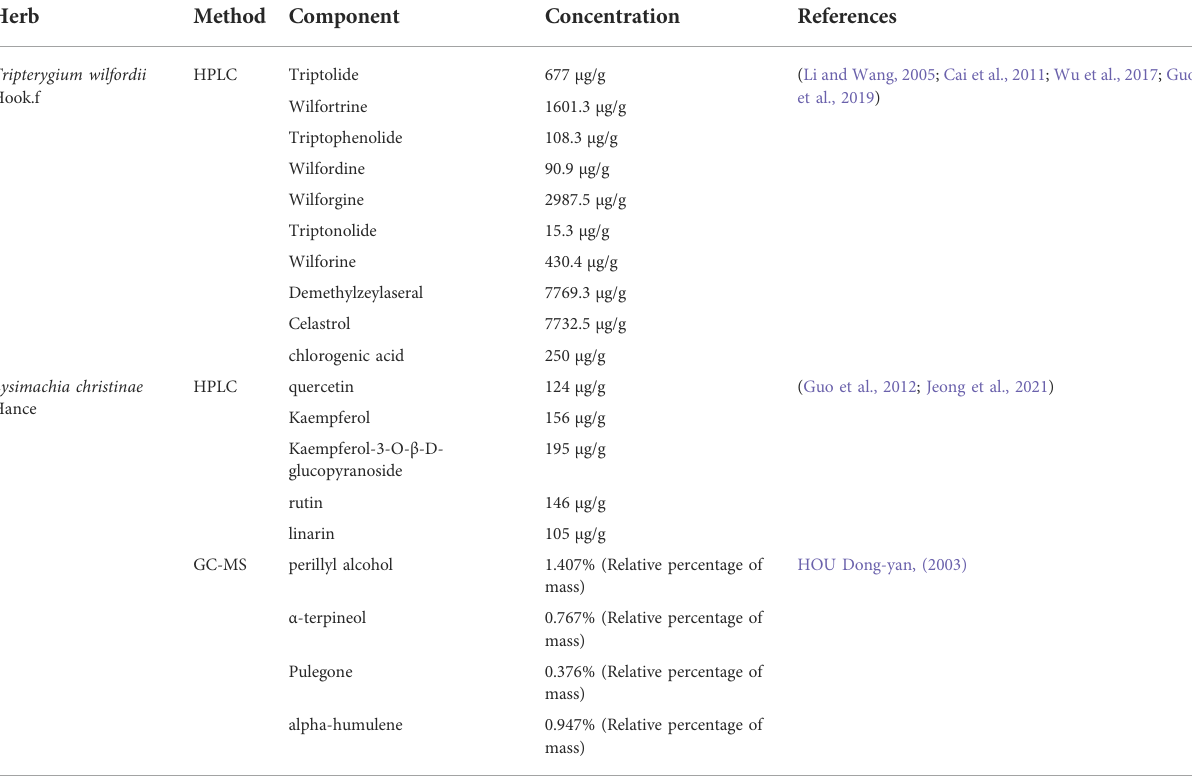
TABLE 1 Experimentally con fi rmed high concentration composition of LGT and